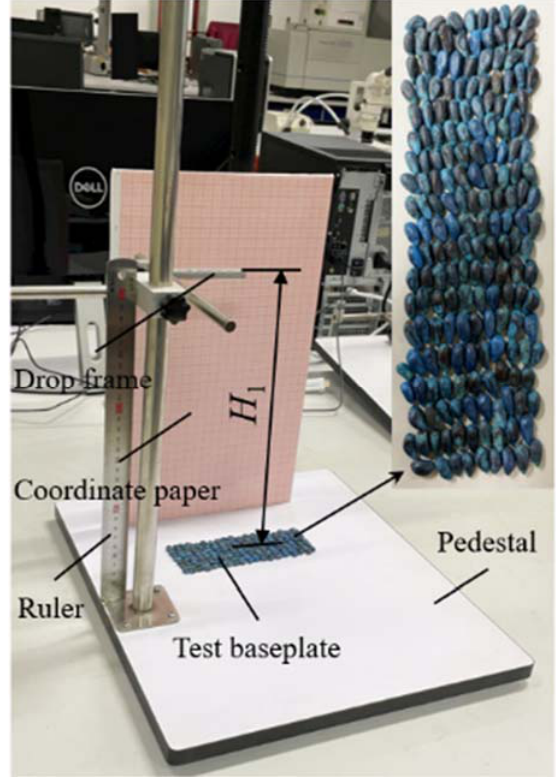
Figure 1. Impact recovery coefficient measuring device.